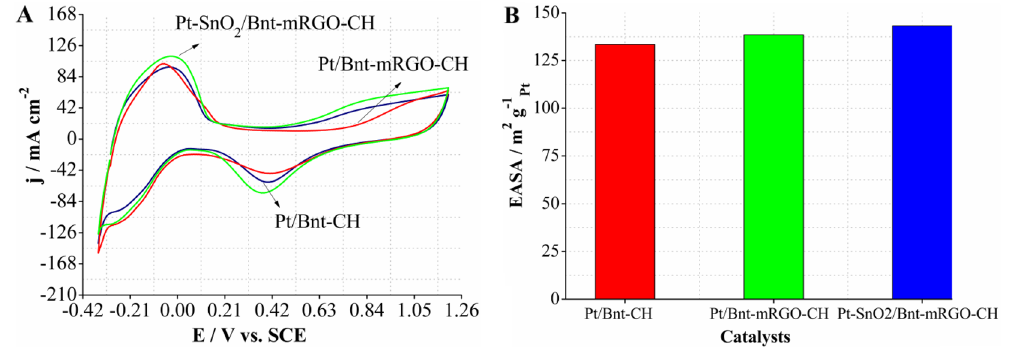
Figure 3. ( A ) Cyclic voltammograms and ( B ) EASA values of the catalysts in 0.5 M H 2 SO 4